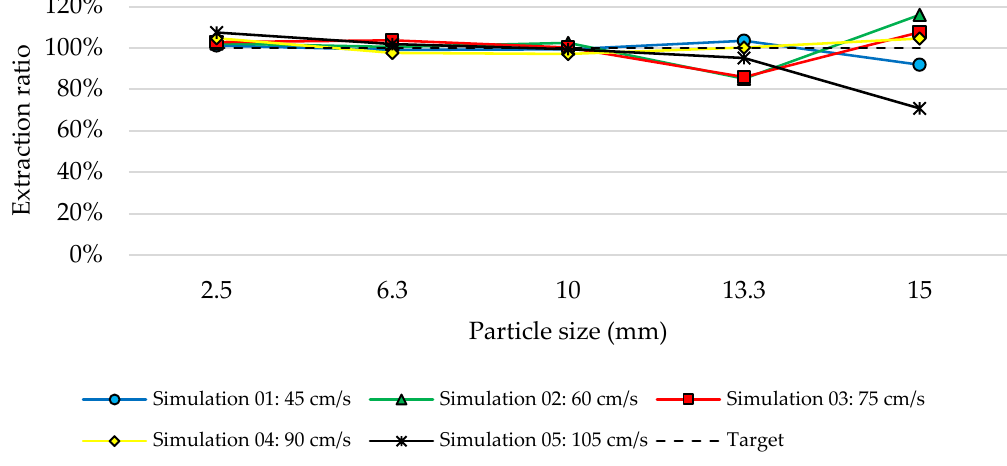
Figure 13. Extraction in cross-stream cutter as function of cutter velocity.